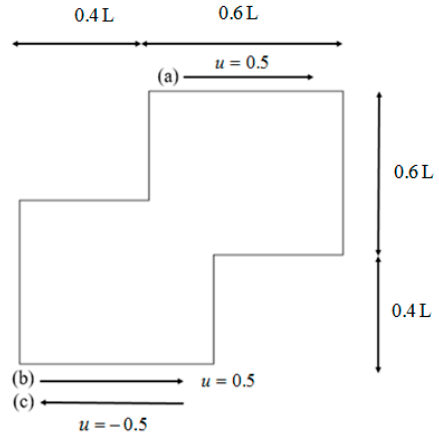
Figure 1. Geometry of problem.